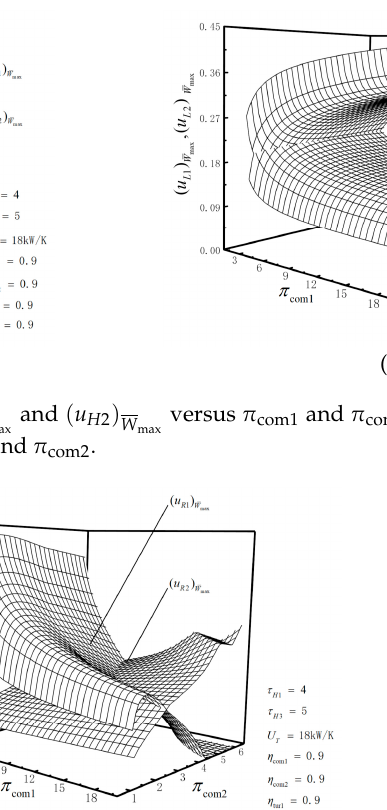
π . Figure 6. Relationships of ( u com2